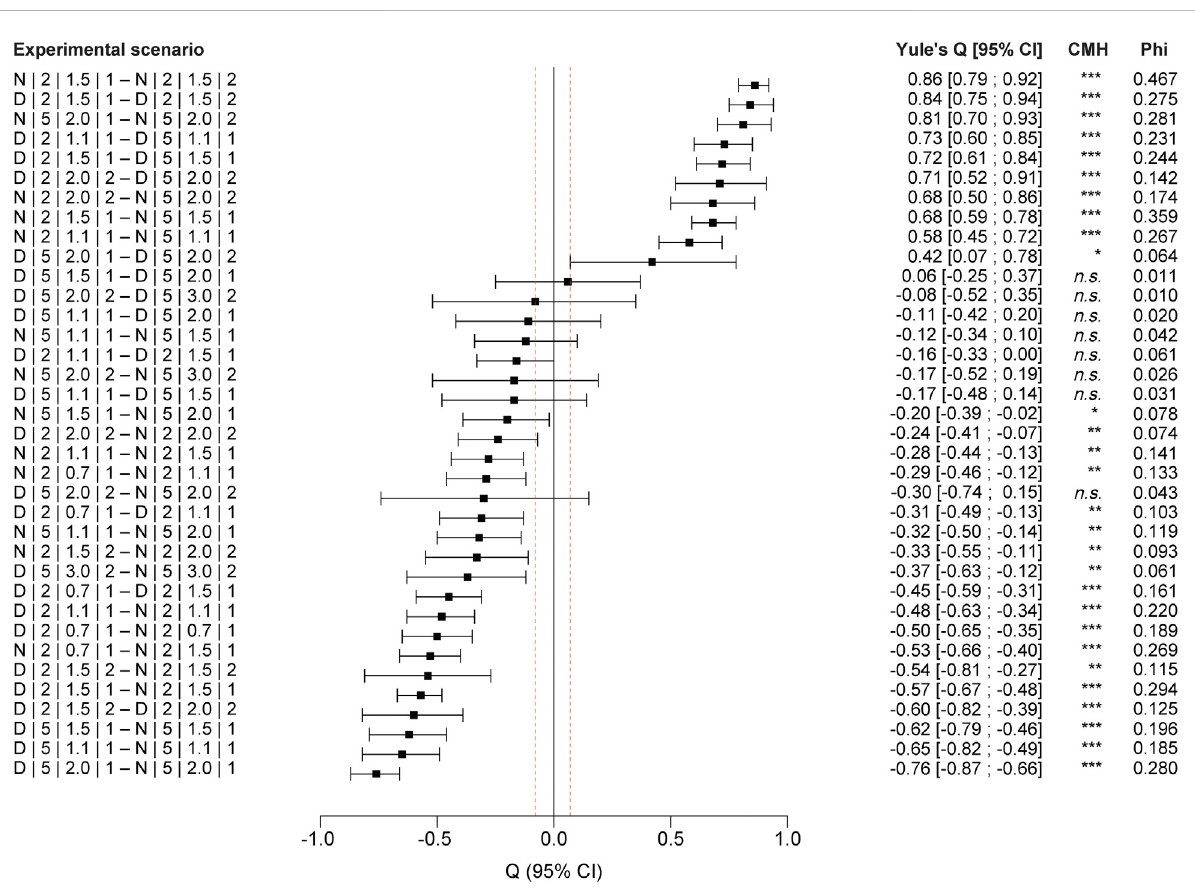
FIGURE 5 Pairwisecomparisonsoftheexperimentalscenarios(forcodingexplanation,seeTable1):Yule ’ sQandcon fi denceinterval(CI);complementary with Cochran – Mantel – Haenszel (CMH) test and power coef fi cient (Phi); sorted by Yule ’ s